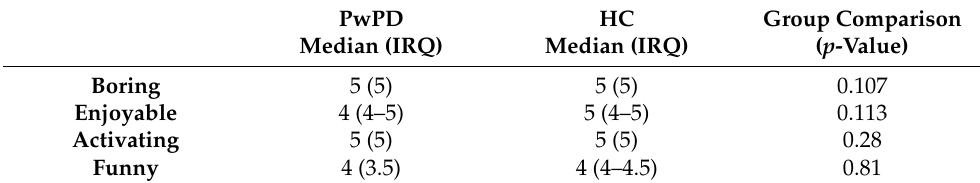
Table 4. Comparison of scores at the subscale enjoyment of IMI.